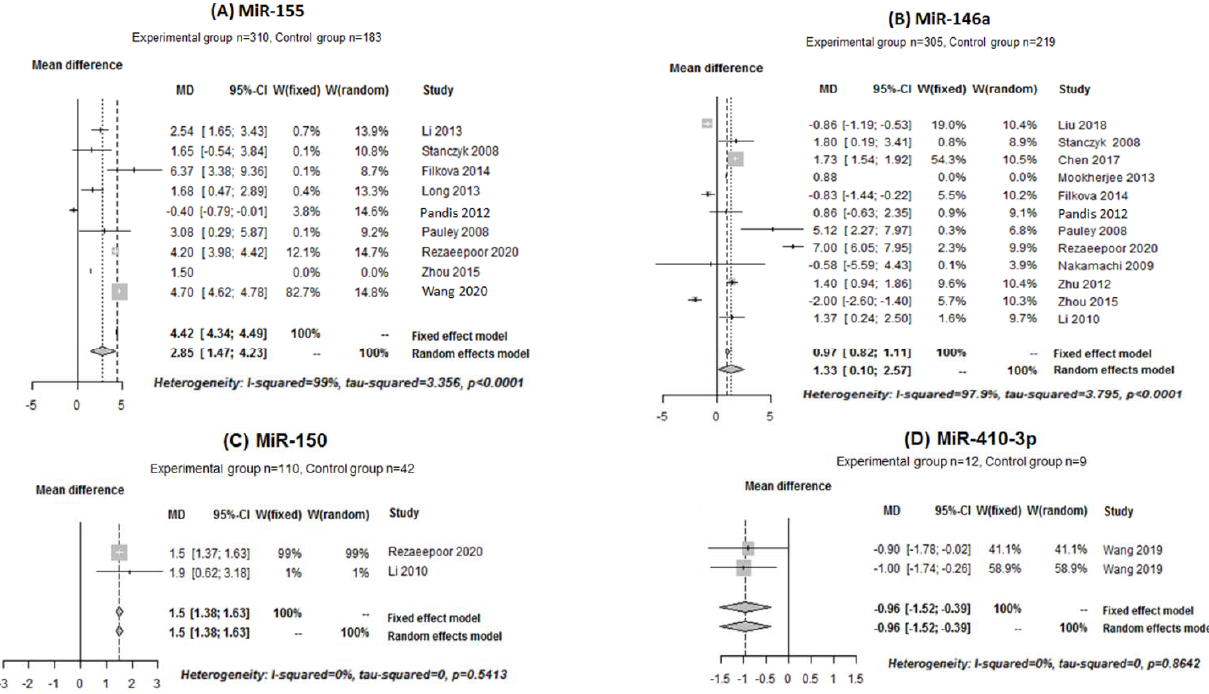
Figure 3. Forest plot of the meta ‐ analysis for the expressions of ( A – D ) in human samples (PBMC, cell culture, sera and blood).